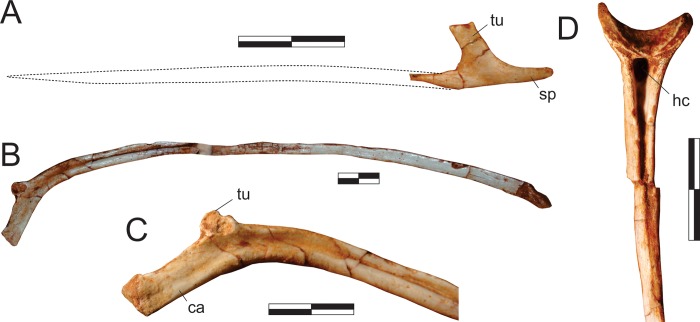
Pampadromaeus barberenai (ULBRA-PVT016) ribs and chevrons.Photographs of ribs and chevron. A, Cervical rib in lateral view; B-C, Trunk rib in caudal view. D, Chevron in caudal view. Abbreviations: ca, capitulum; hc, haemal canal; sp, spine; tu, tuberculum. Dashed lines indicate inferred skeletal margins. Scale bar = 1 cm.